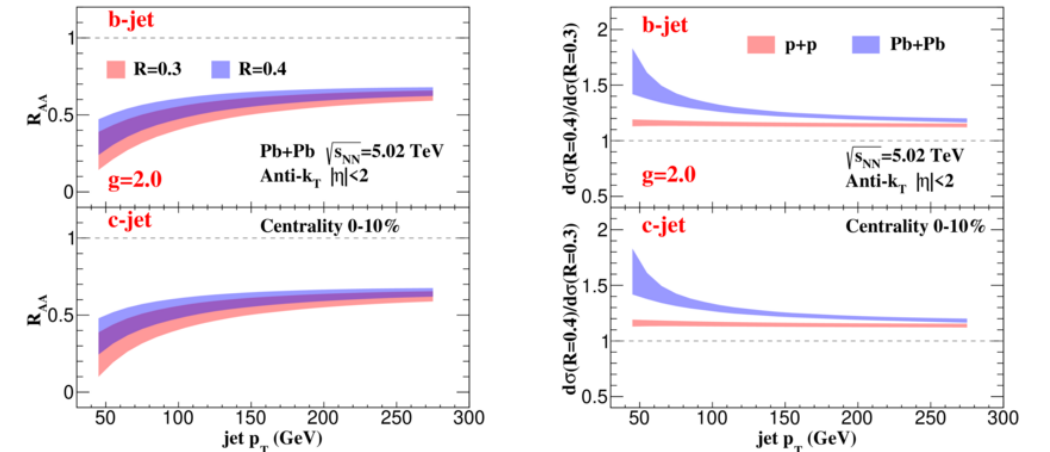
Figure 7 . The heavy flavor tagged jet nuclear suppression factor R ratio for different radii (right). In the left plot, the red and blue bands represent the R and 0.4, respectively. The cross section ratio is defined as dσ ( R =0 . 4) blue bands for p+p and Pb+Pb collisions, respectively. The upper panels present our results for b-jet and the lower ones for